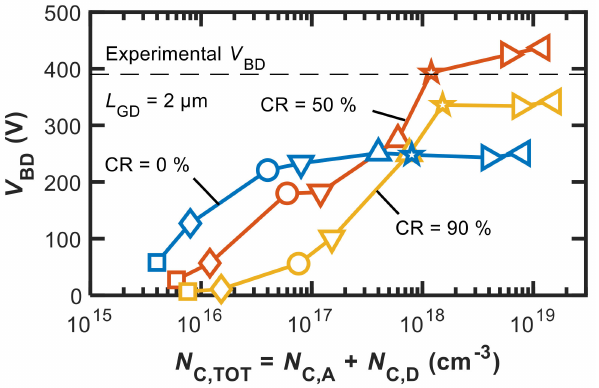
Figure 4. V BD vs. N C,TOT for CR = {0, 50, 90}%. The same symbols correspond to the same N C,A at different N C,D depending on